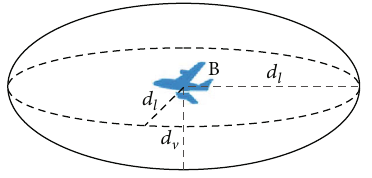
Figure 3: Ellipsoidal fl ight protection